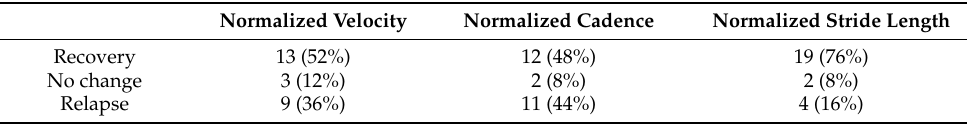
Table 3. The general effect of rehabilitation in the study group (n = 25).